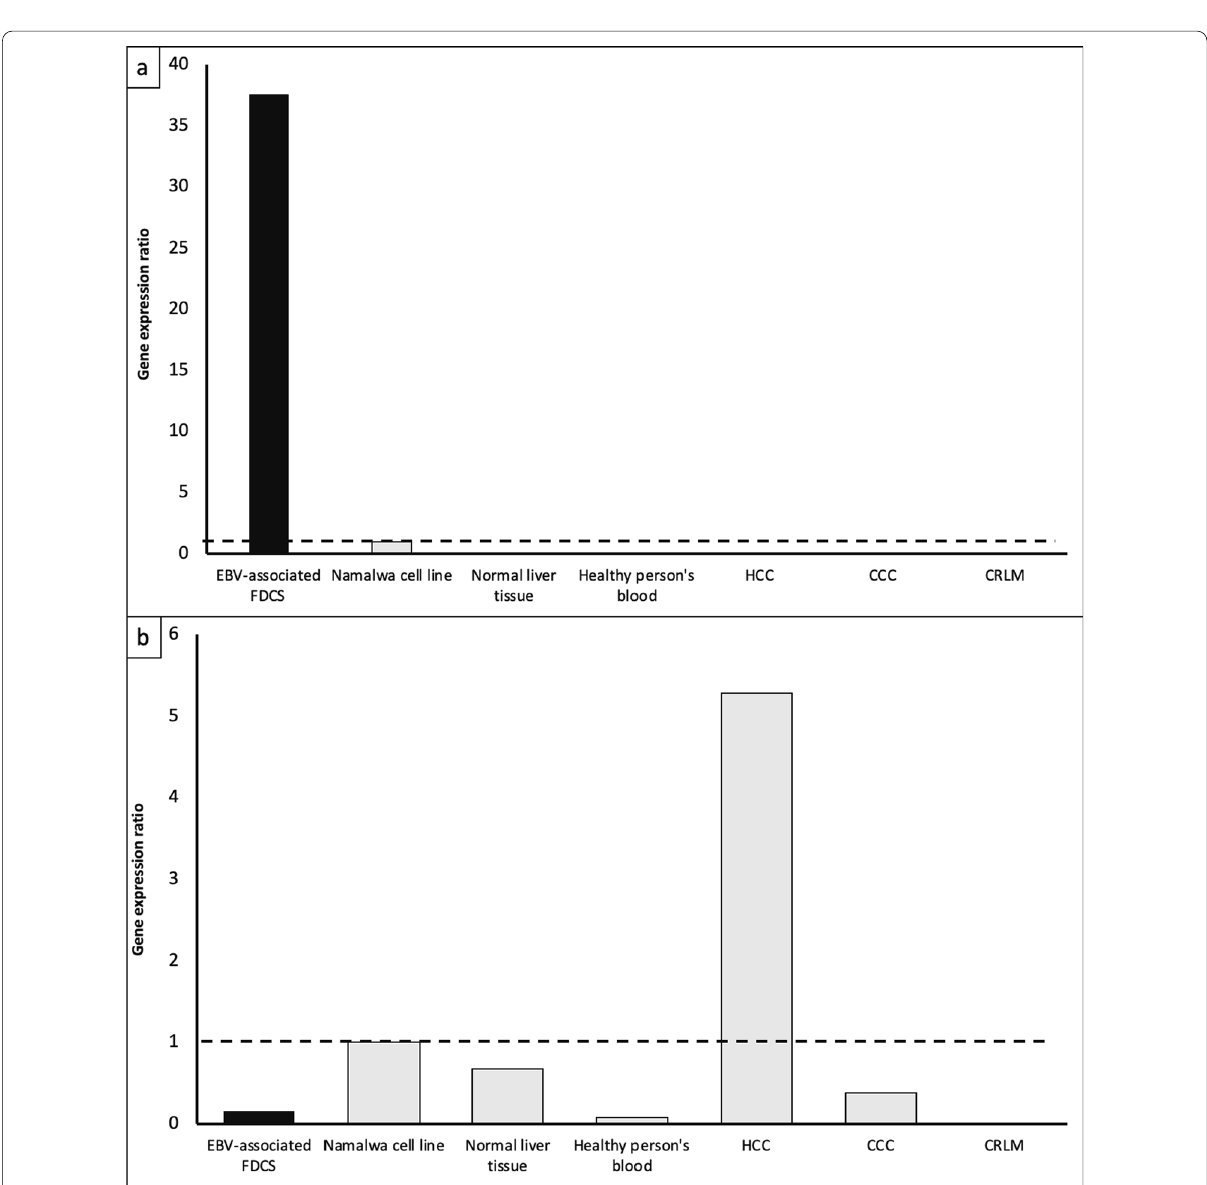
Fig. 4 Real-time PCR analysis for gene expression. a PCR products were analyzed using the ΔΔCt method, and the LMP-1 gene expression ratios in the tumor samples were calculated by setting the ratio for Namalwa cell line as 1. b PCR products were analyzed using the ΔΔCt method, and the EBNA-2 (human CXCR7 ) gene expression ratios in the tumor samples were calculated by setting the ratio for Namalwa cell line as 1. EBV: Epstein– Barr virus; FDCS: follicular dendritic cell sarcoma; HCC: hepatocellular carcinoma; CCC: cholangiocellular carcinoma; CRLM: colorectal liver metastasis; PCR: polymerase chain reaction; LMP: latent membrane protein; EBNA-2: EBV nuclear antigen-2; CXCR7: C–X–C Chemokine Receptor type